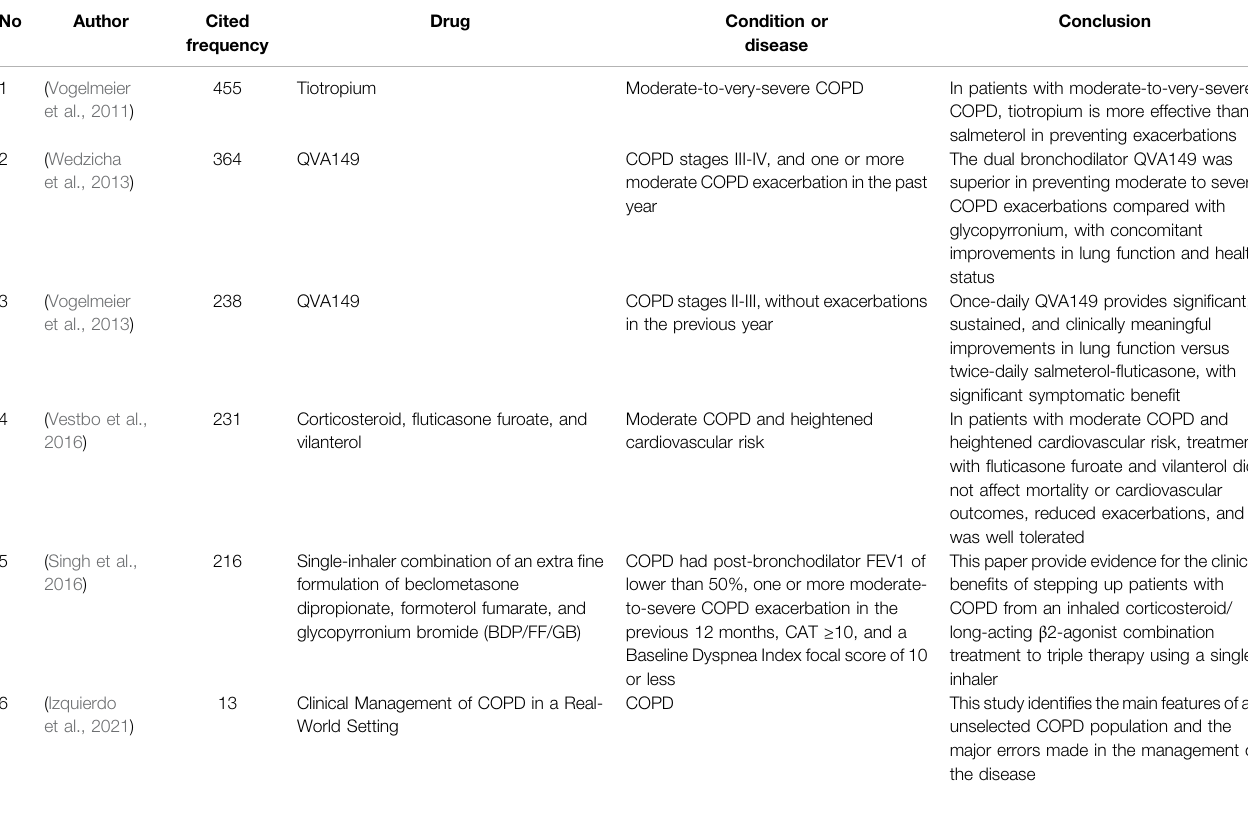
TABLE 5 | The top 5 cited COPD drugs-related studies that were published from 1980 to 2021 and the most cited papers in